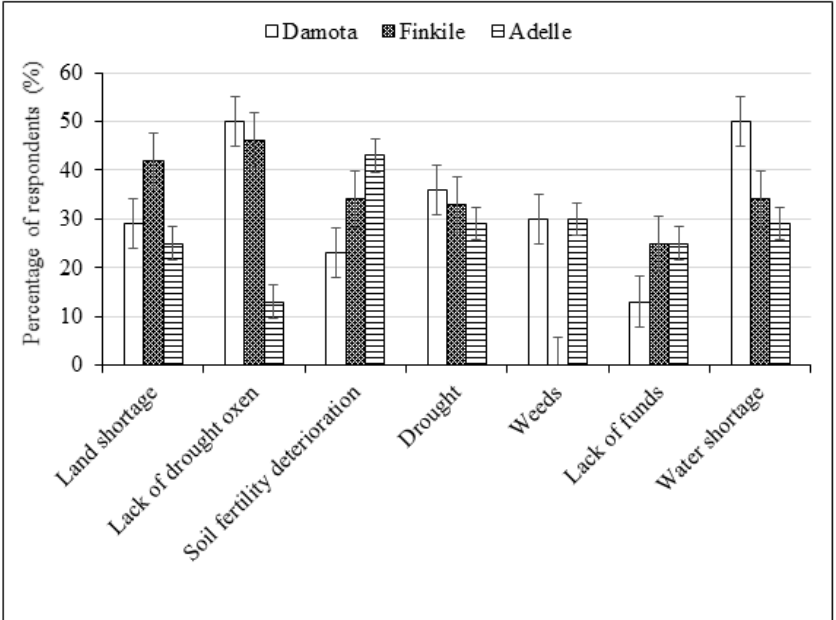
Figure 3. Crop yield trend within the last 10 years of the three selected kebeles of the Haramaya District (Source: Elaborated by the Authors).